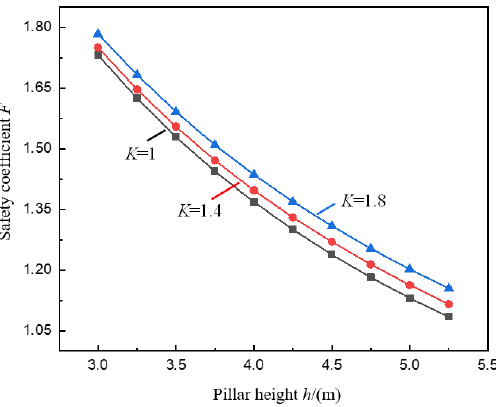
Figure 4. Variation curve of pillar safety coefficient F with goaf span b .